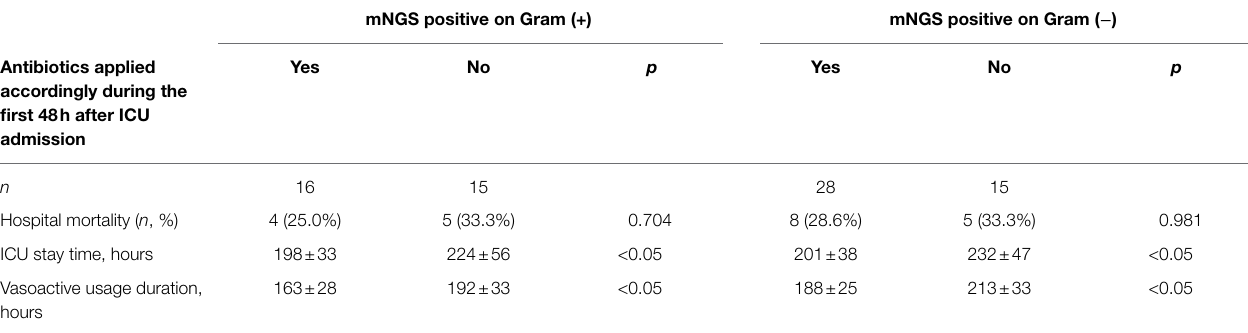
TABLE 2 | Clinical outcomes of the patients with mNGS positive according to whether received the mNGS matched antibiotics during the first 48 h after ICU admission. mNGS positive on Gram